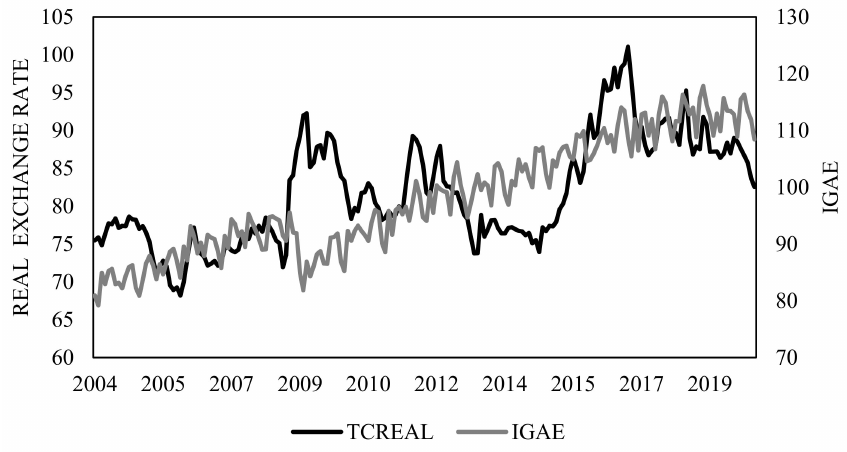
Figure 3. IGAE and Real Exchange Rate from 2004 to 2020. Note: The monthly data are from 2004 to February 2020. IGAE stands for the Global Indicator of Economic Activity and is displayed on the right vertical axis. Source: Own estimations using data from INEGI and Banco de Mexico.